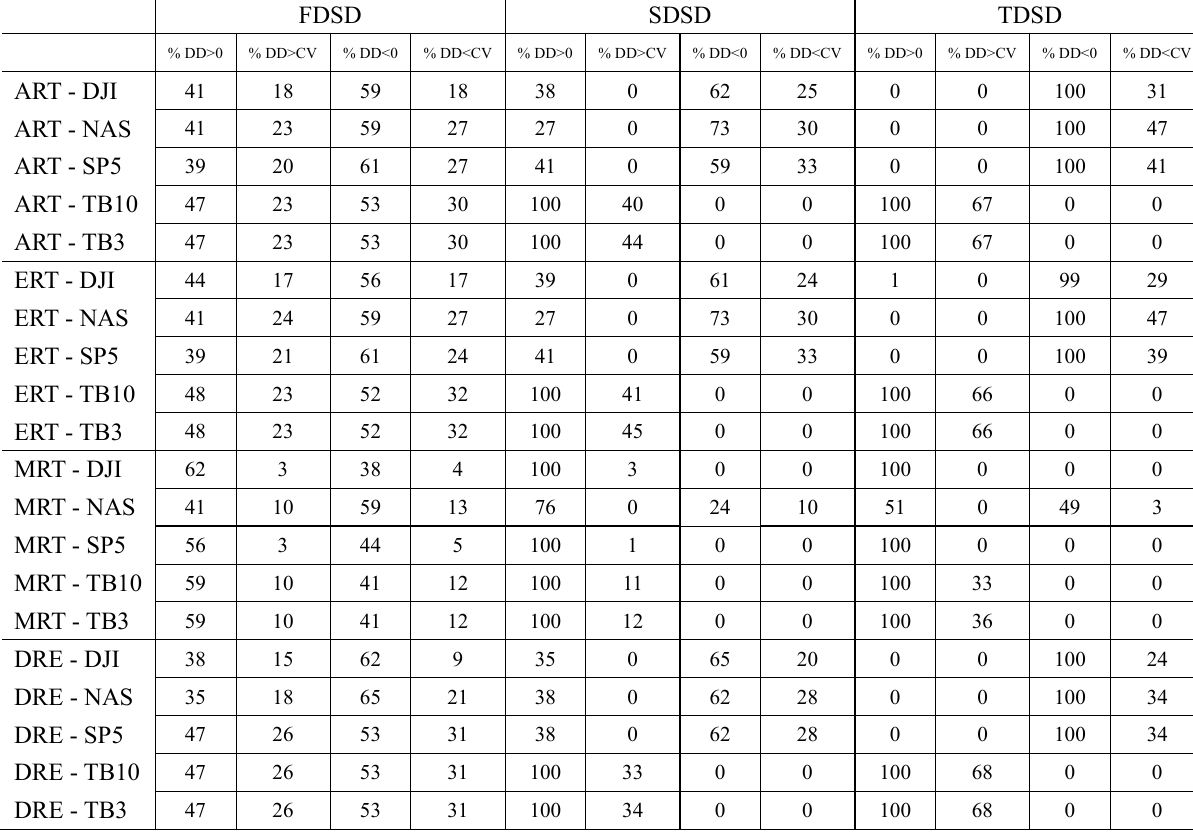
Table 3: Results of DD Test for Risk-Seekers